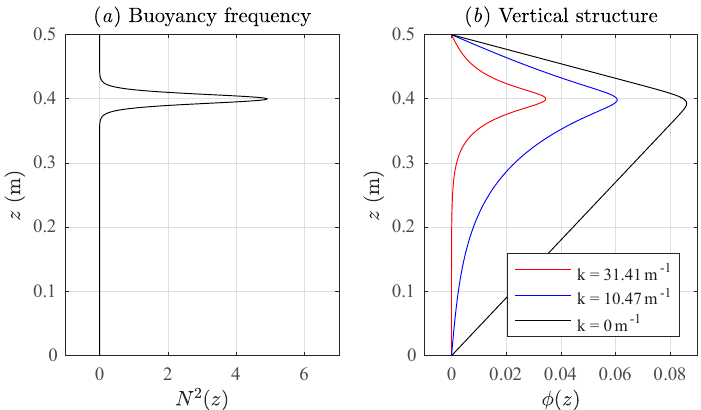
Figure 1. Example of (a) buoyancy frequency profile and (b) vertical structure profiles as the wave number varies for mode-1 internal waves in a zero-background current. The amplitudes of the eigenfunctions have been varied for clarity of visual